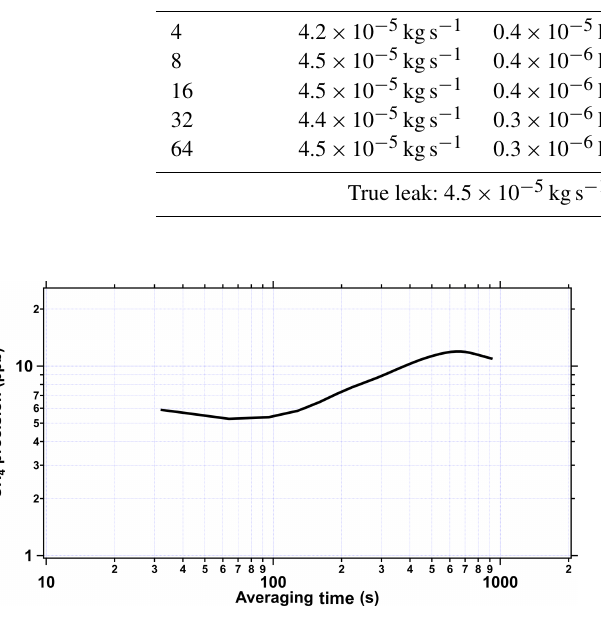
Figure 9. Allan deviation plot showing changes in measurement precision with averaging time from field data collected at Ta- ble Mountain on 26 January